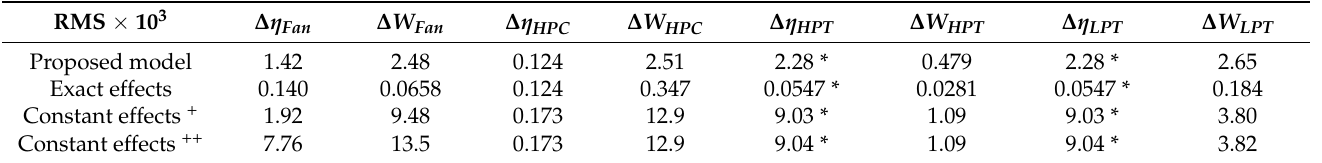
Table 12. Actual and estimated RMS value of health parameters, without measurement noise for various installation effect estimation methods. * Efficiency equal hurt assumed. + Pressure recovery according to proposed model. ++ Pressure recovery according to